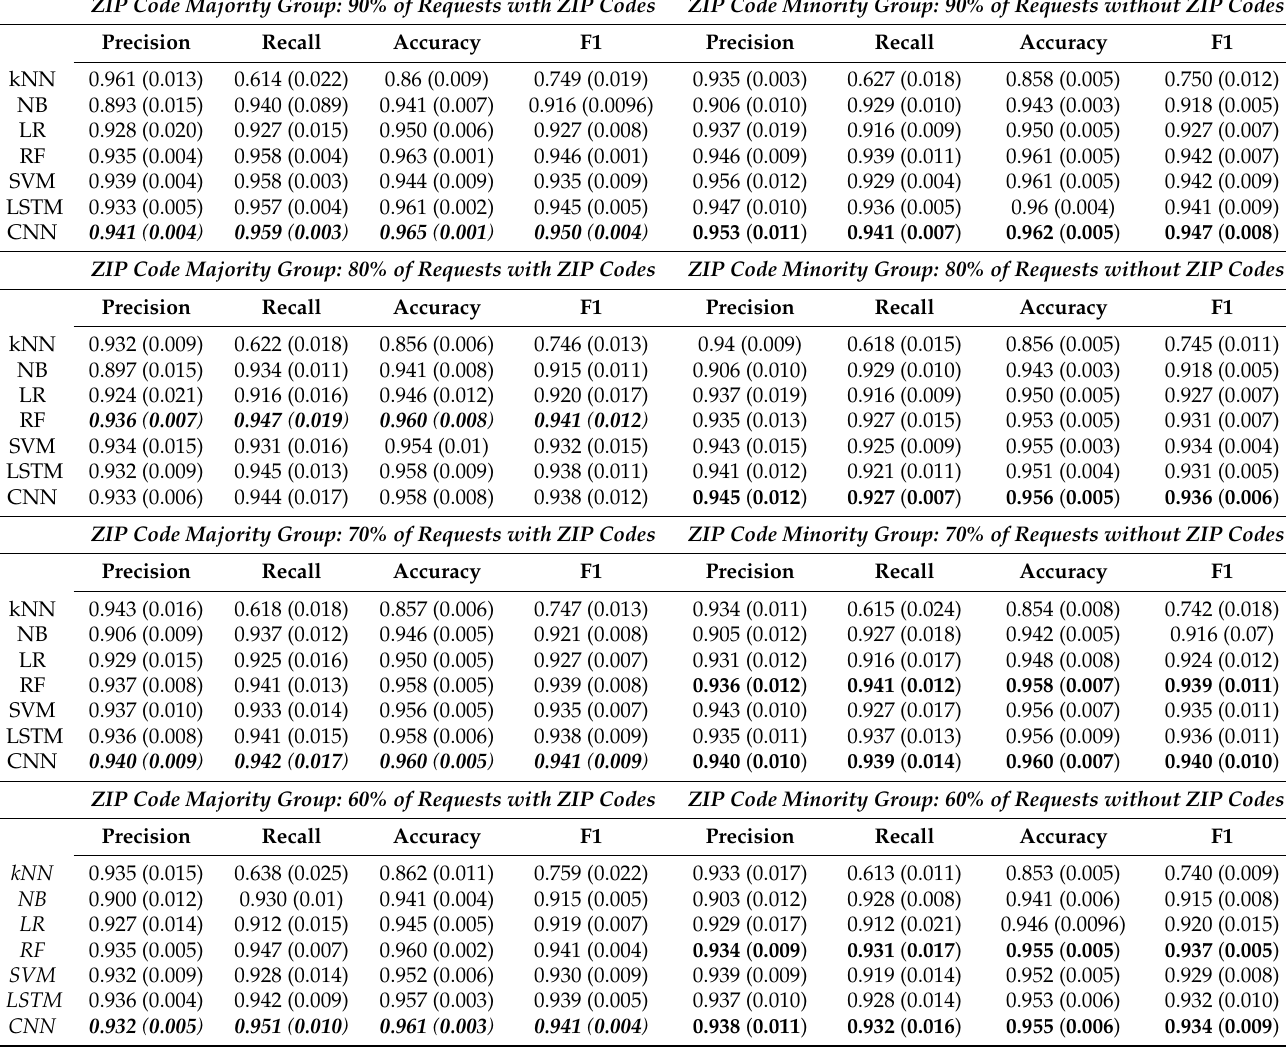
Table 2. Model evaluation results with different percentages of ZIP-code-tagged positive